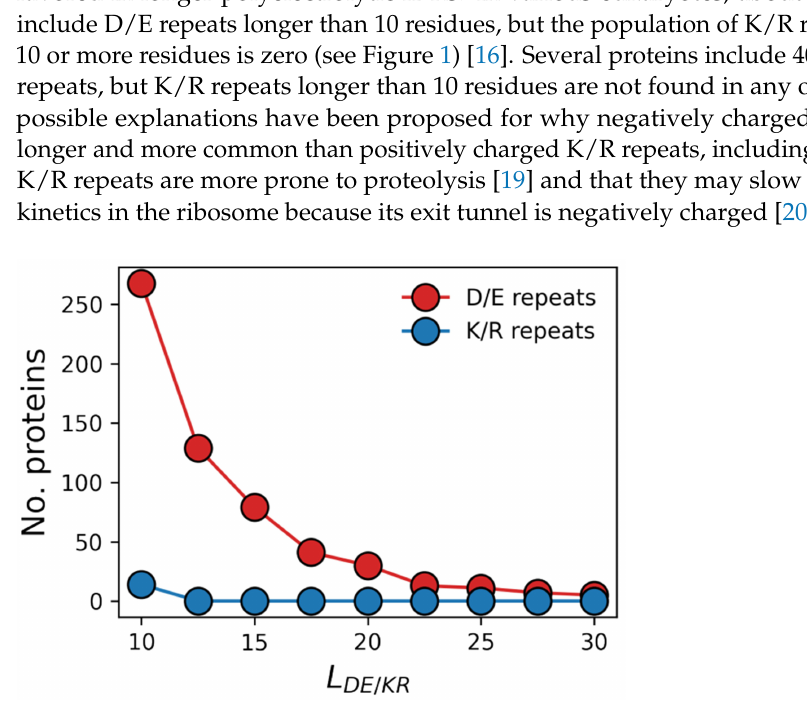
Figure 1. Occurrence of proteins with negatively or positively charged polyelectrolytic intrinsically disordered regions (IDRs) in the human proteome. Protein abundance is shown for proteins with D/E or K/R repeats of various lengths, as represented by L DE/KR (i.e., the number of charged residues in the negatively or positively charged homo-polypeptides). The indicated number of proteins (out of the 20,600 proteins in the human proteome) is a cumulative value for all D/E or K/R repeat lengths up to the value of the corresponding L DE/KR . The shortest repeat length in this analysis is a repeat of 10 residues.